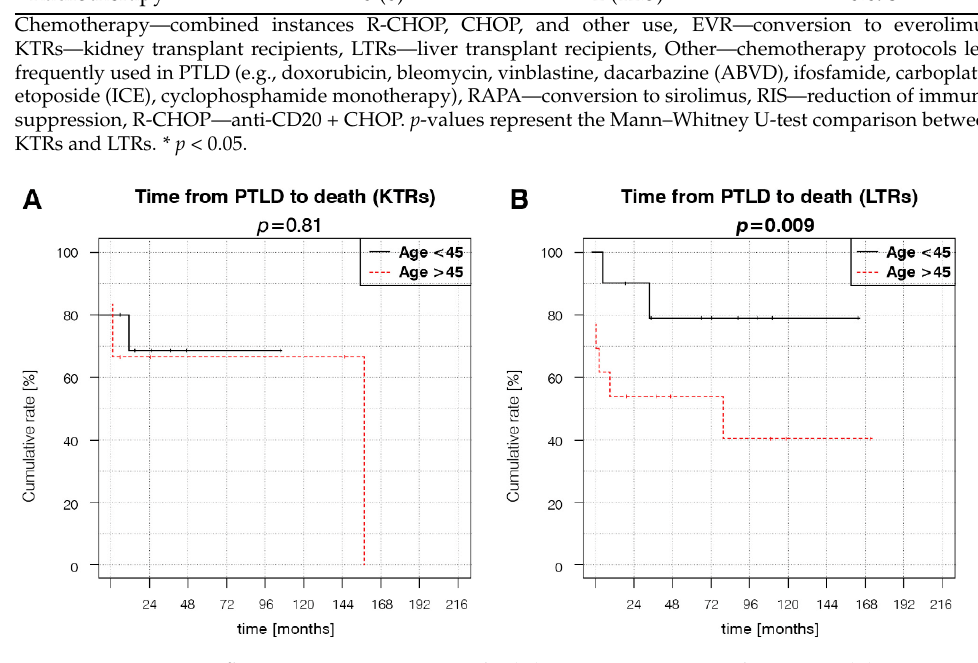
Figure 3. Factors influencing patient survival. ( A ) KTR age at transplantation, ( B ) LTR age at transplantation. p -values represent the log-rank analysis of the Kaplan–Meier estimator curves.